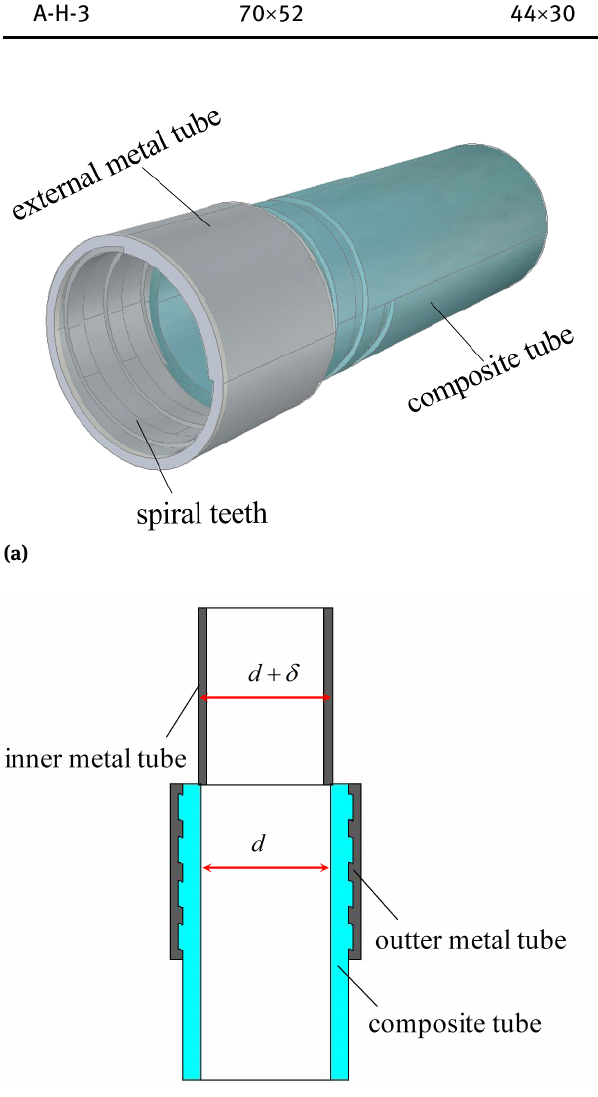
Figure 5: (a) Metal tube installed into the composite tube (b) Dia- gram of interferential fit